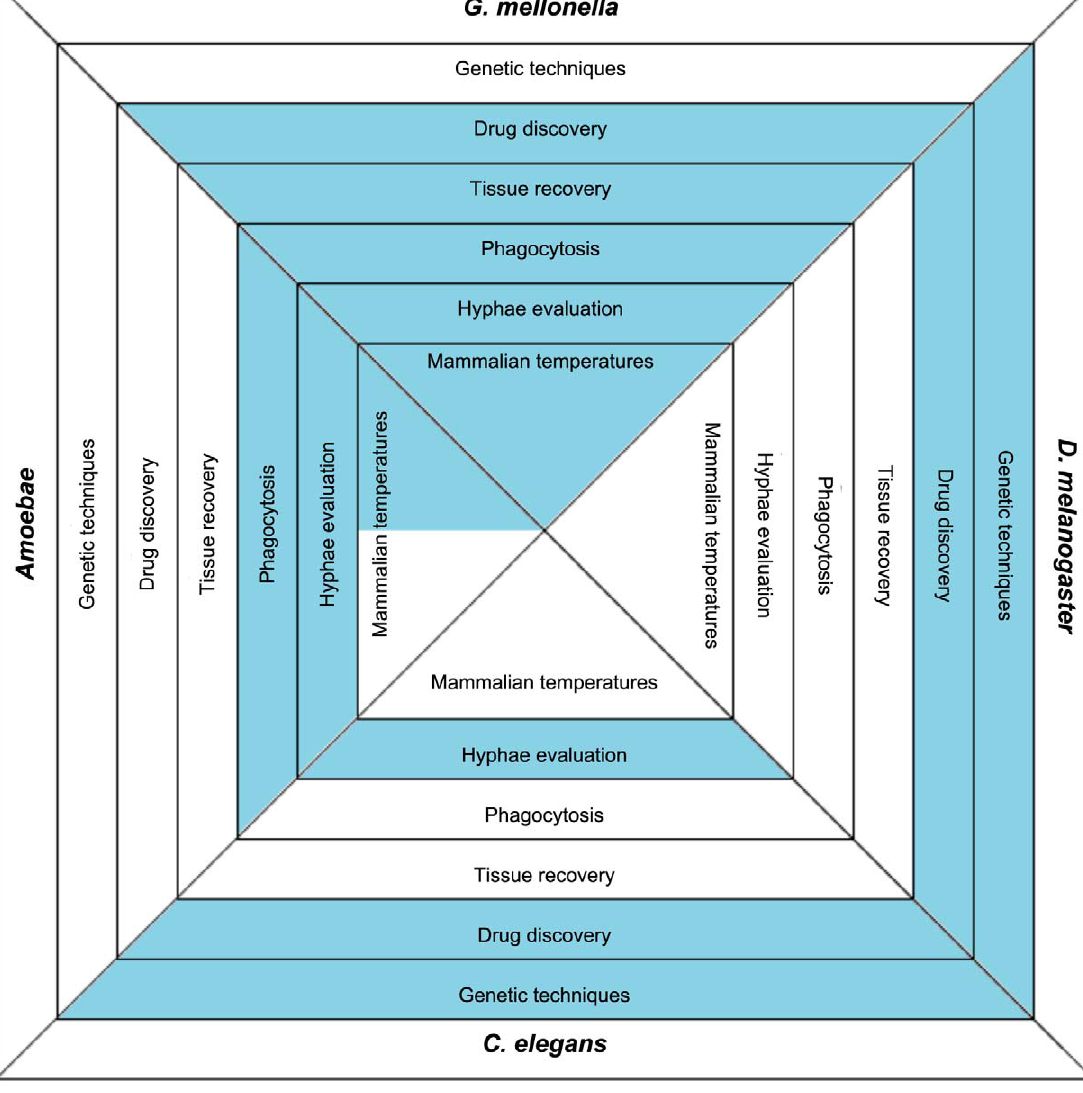
Figure 1. The basic characteristics of the more frequently used model hosts. The blue color indicates that this feature is found in the specific model host. Utilizing the features of the chart can aid in determining which host(s) are most amenable to a particular study. Host genetic tools aiding in understanding host–pathogen interaction include sequenced genomes, available mutant strains, or RNAi. Once infected, some hosts can be used to identify compounds with antifungal activity. Also, while infected, some hosts are large enough that individual portions or tissues from the hosts can be removed and further analyzed either for host responses or to evaluate tissue invasion by the pathogen. As part of the host response, some hosts have phagocytic cells that engulf the foreign fungi and can be studied to elucidate information about host–pathogen interactions. When some fungi are engulfed by phagocytes, or establish an infection within the hosts, they produce hyphae. Because of the transparency or ability to recover tissue from some of the hosts, fungal hyphae formation can be further evaluated. For all of the infecting pathogens, temperature conditions are a consideration. The various hosts have conditions that are ideal for meeting their own survival needs, and the fungi will react differently in terms of gene expression and growth rate based on the temperatures in which the hosts are maintained. Temperature features marked in grey on the chart indicate hosts that can survive at temperature ranges as high as 37 u C. Other invertebrate model hosts including Bombyx mori , Culex quinquefasciatus , Blattella germanica , and even a plant model of Arabidopsis thaliana have been developed. They are not as widely used and not mentioned here in detail because of space limitations.